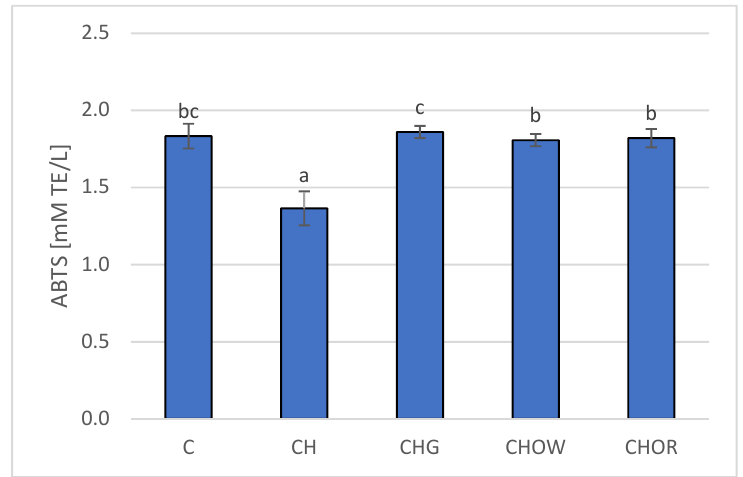
Figure 3. Changes in plasma antioxidant activity (ABTS) in rats fed control and cholesterol-containing (1% of cholesterol) diets supplemented with lyophilized vegetables (garlic, white onion, and red onion) during the 28 day experiment. Values are means of 6 measurements ± SD. Means in bars with different superscripts letters in common differ significantly ( p < 0.05 ). Abbreviations: C—control group; CH—control group with 1% of cholesterol; CHG—group with 1% of cholesterol and lyophilized garlic addition; CHOW—group with 1% of cholesterol and lyophilized white onion addition; CHOR—group with 1% of cholesterol and lyophilized raw red onion addition; ABTS—plasma antioxidant activity measured by ABTS test (ABTS—2,2’-Azino-bis-(3-ethyl-benzothiazoline-6-sulfonic acid) diammonium salt).